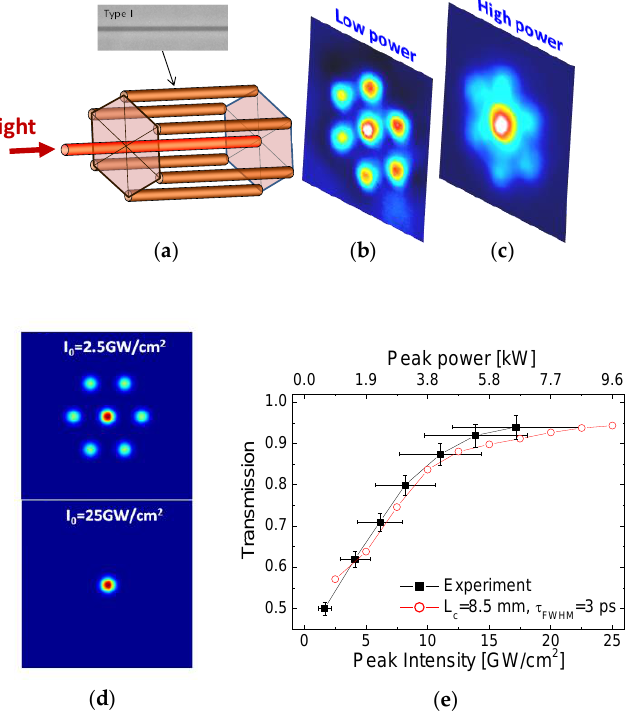
Figure 12. ( a ) Conceptual design of the centered hexagonal array with a 9.1 mm length for the core guide and a 2.4 mm length for the surrounding hexagon. The inter-trace spacing is 13 µ m; ( b ) Output mode in the case of low-power (0.2 kW) injection with a uniform spread of energy; ( c ) Output mode in the case of high-power (7 kW) injection with a core localization of light. The injected pulse duration (FWHM) is 3 ps; ( d ) Output mode snapshots resulting from the simulation of the propagation in the photonic saturable absorber of a λ = 800 nm positively chirped pulse of 3 ps, for an input pulse intensity of 2.5 GW ∕ cm 2 (top) and 25 GW ∕ cm 2 (bottom); ( e ) Intensity and power-dependent transmission in the hexagonal array. Experimental values (solid squares) and simulation data (open circles) are plotted. The x-error bars reflect the precision in evaluating the intensity via the accuracy of mode size estimations.